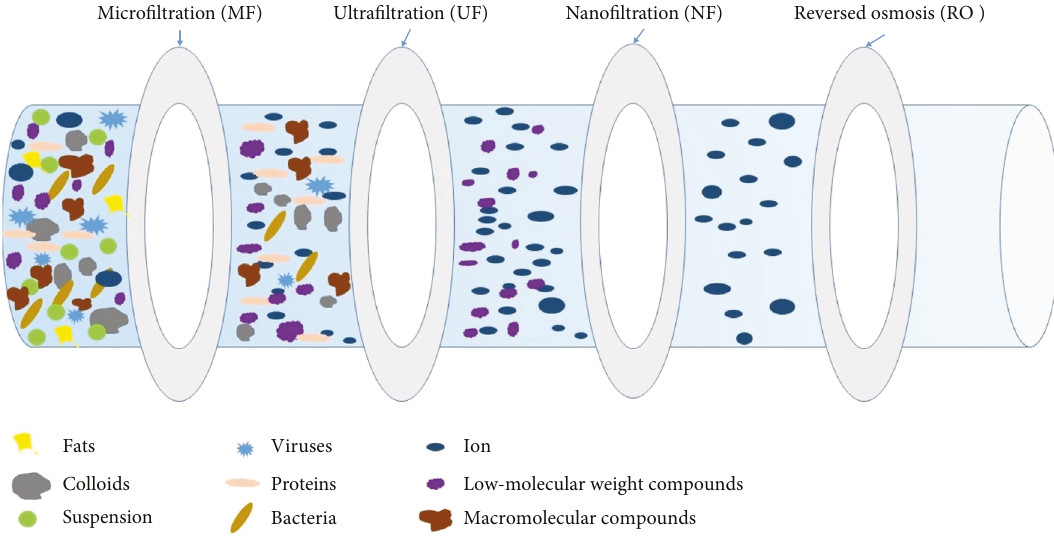
Figure 1: Separation in pressure membrane techniques depending on the size of the components [1 –